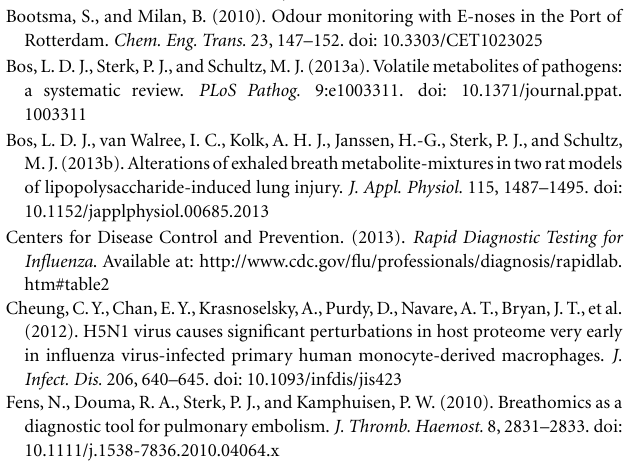
non-infected profile. Red fingerprints represent cases that were most similar to the infected profile. There is a new suspected case in Italy, the molecular signature is now compared to the profiles in the